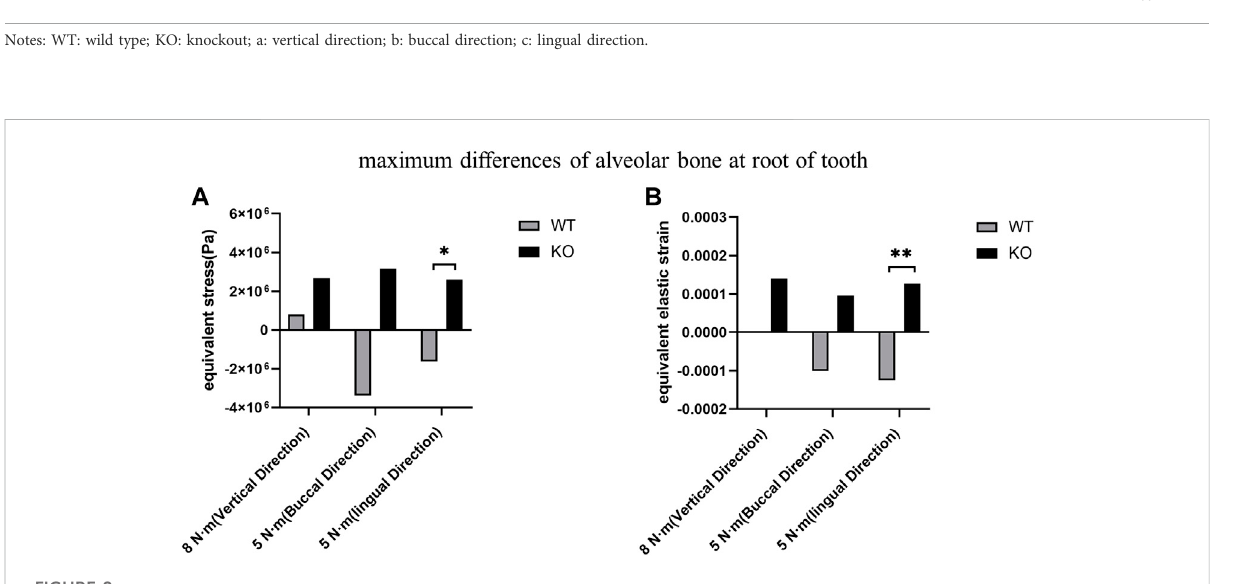
FIGURE 8 ComparisonofthemaximumdifferencesbetweenKOmiceandWTmice. (A) Maximumstressdifferencesofthealveolarboneatthetoothroot. (B) Maximum strain differences of the alveolar bone at the tooth